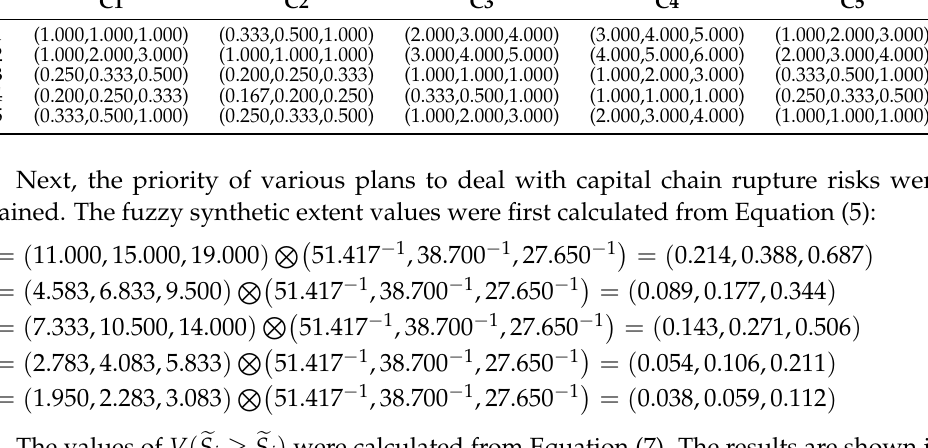
Table 4. Direct comparison matrix under conditions of decision failure occurrence (cid:103) DC